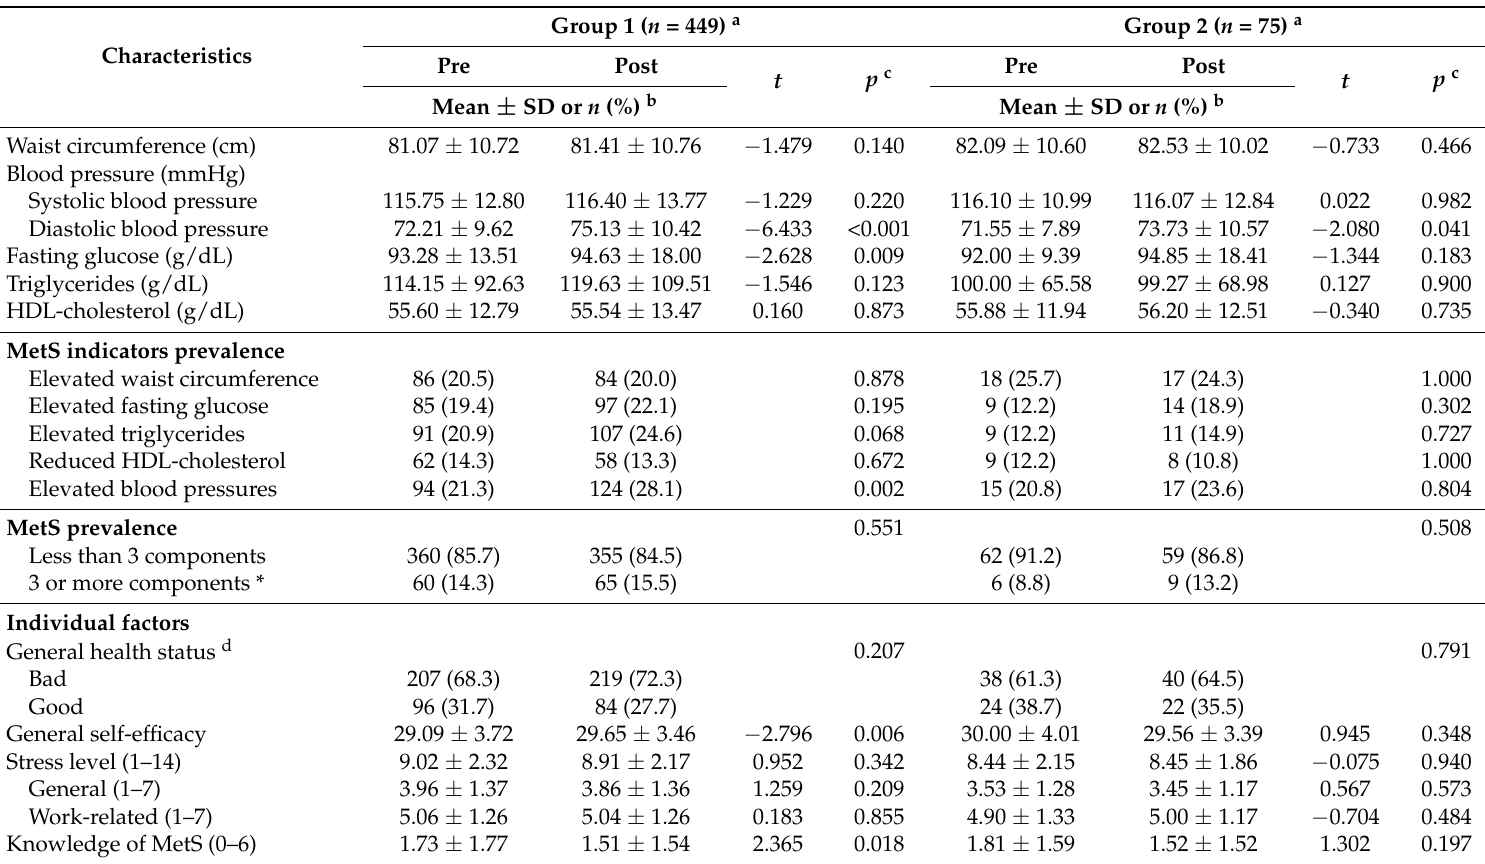
Table 3. Pre- and post-results of participants by regular health examinations (Group 1, Group